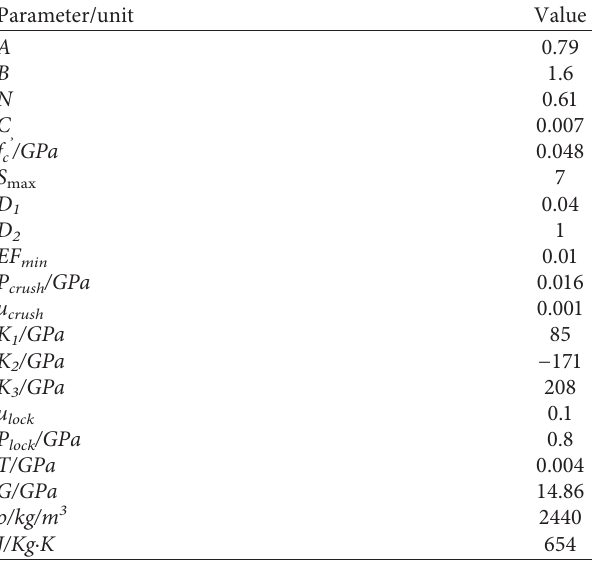
Figure 1: Finite element model of cutting rock. Table 1: Parameters of the finite element